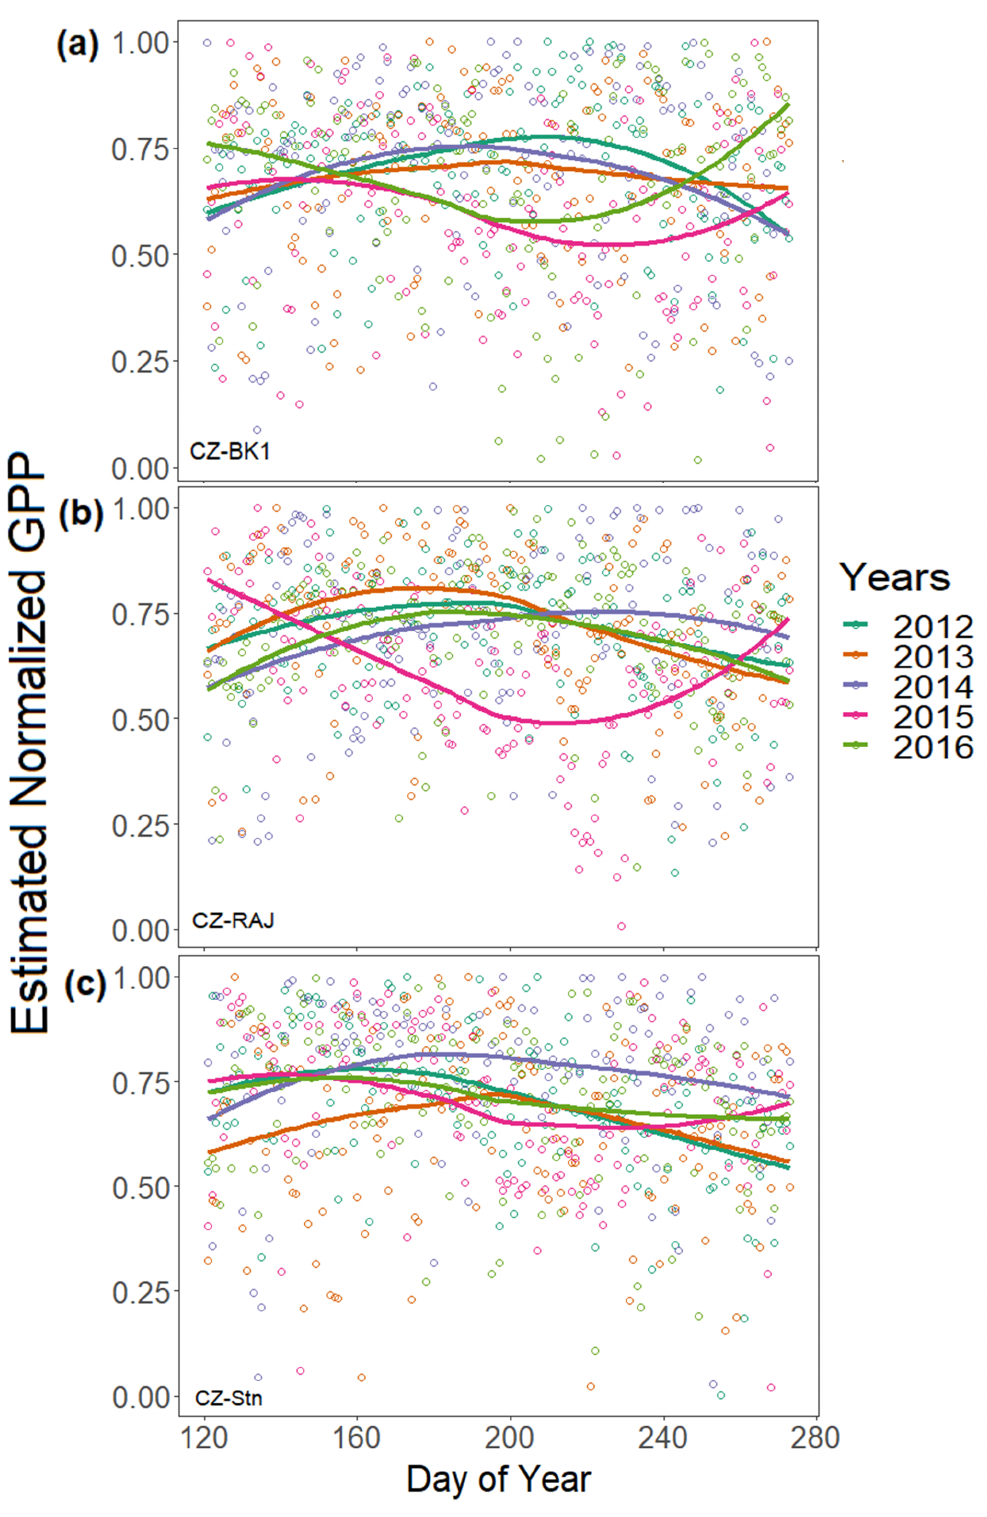
Figure 3. Annual variations of estimated Normalized gross primary productivity (GPP norm ) within ( a ) the wet spruce forest in Bílý K˘rí˘z (CZ-BK1), ( b ) the dry spruce forest in Rájec (CZ-RAJ), and ( c ) the beech forest in Štítná (CZ-Stn) from May to September of 2012–2016. The smoothing spline curves was depict the trends in seasonal courses of GPP norm during the growing seasons of 2012–2016. The smoothing spline curves ( λ = 0.95) depict the trends in changes of daily GPP norm values over the growing seasons of